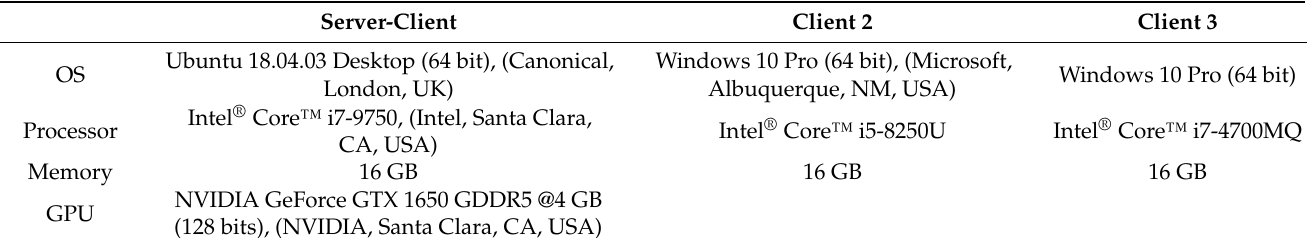
Table 1. Hardware setup of our system.